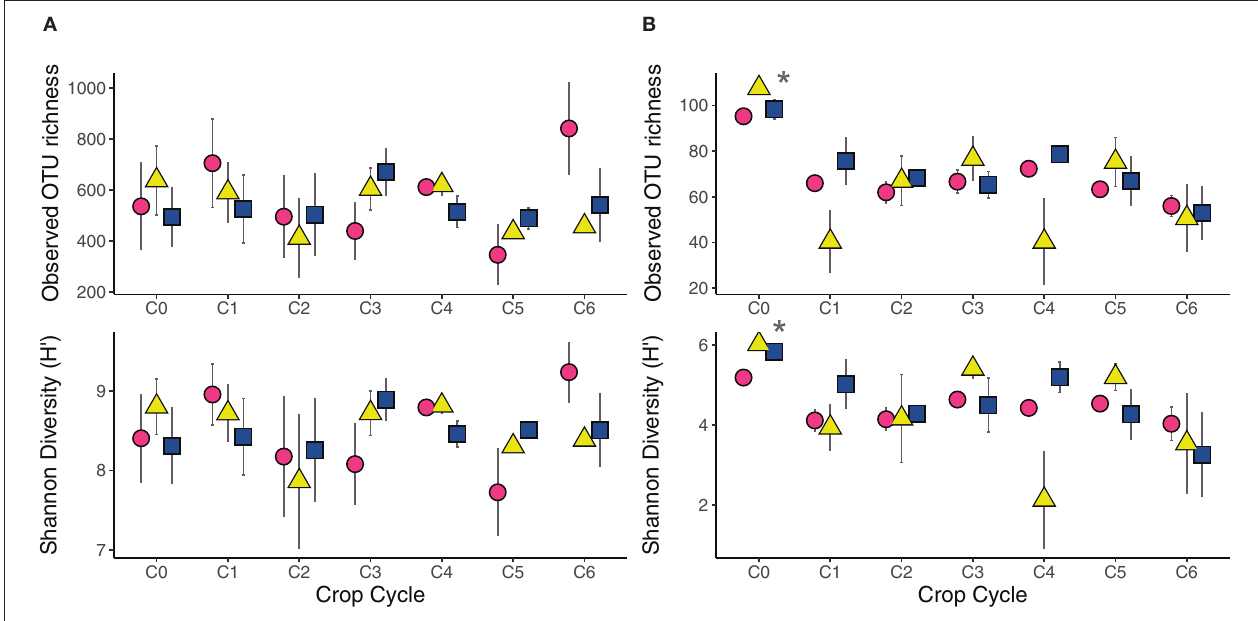
FIGURE 2 | Observed OTUs and Shannon’s Diversity index measuring the community responses of (A) prokaryotes and (B) fungi to fertilizer treatments over six crop cycles, including soils prior to planting (C0). Circles indicate compost treatment, triangles indicate urea treatment, and squares indicate controls. Asterisks (*) denote significant treatment differences across all crop cycles. Error bars indicates standard error.